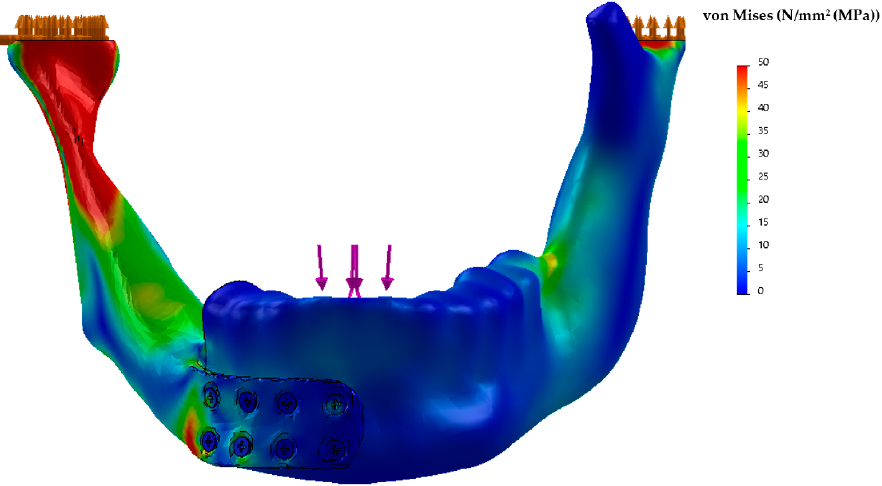
Figure 6. Finite element analysis (FEA) showing von Mises stress concentration on the prosthesis on the conjunction margin of the plate with the first lower right screw (the peak stress was 50 MPa) and on the interior surface of the condylar portion of the plate (the peak stress was 50 MPa). FEA was conducted assuming a static load of 600 N on the central incisors (purple arrows) also resulting in an upward load on both condylar surfaces for elevator muscles action (orange arrows).